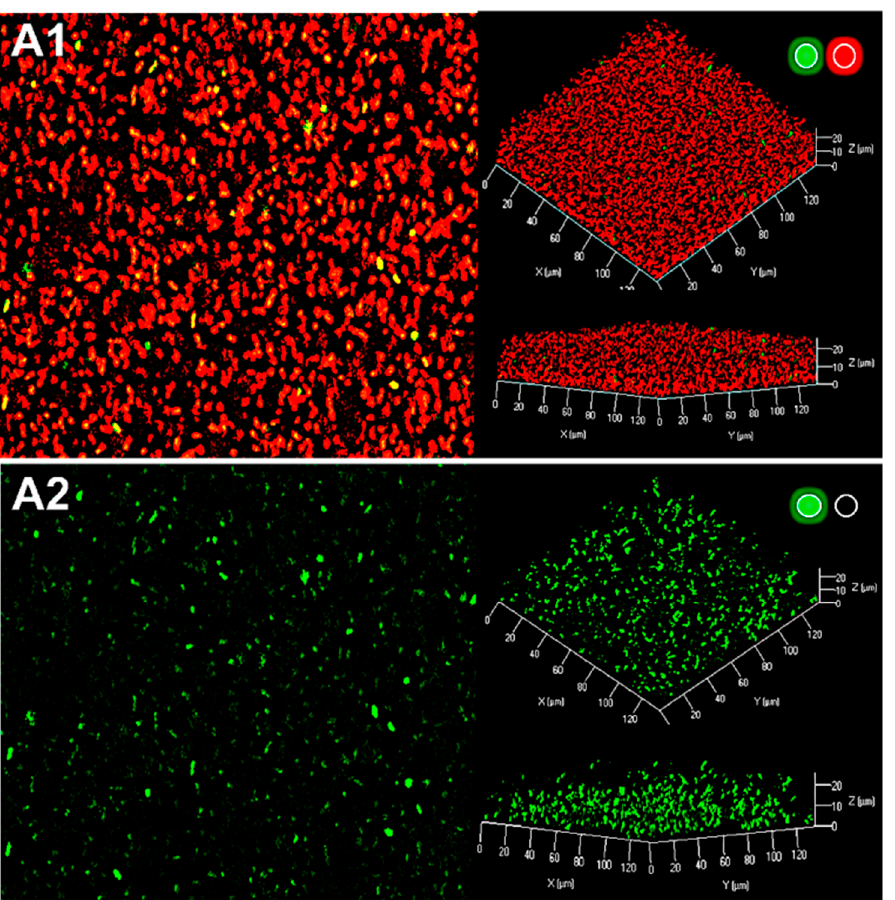
Figure 3. Production of rhizobial AHL signaling molecules within the biofilm. CLSM analysis of the dual-species biofilm formed by R. rhizogenes 5520 T and the P. atrosepticum 6267-EI AHL biosensor strain (1:1 ratio). Bacteria were labeled with the nucleic acid stain Syto 61 (bright red fluorescence), whereas the P. atrosepticum 6276-EI AHL-biosensor was also tagged by GFP, due to the gfp expression governed by the AHL inducible promoter. Top view, 3D shadow representation and side view of the biofilm produced by a mixed culture of R. rhizogenes and P. atrosepticum ( A1,A2 ) . We analyzed the structure of the biofilm (bright red fluorescence) due to the activation of the green plus red channels for ( A1 ), and used the green channel only for ( A2 ), for visualization of the presence of AHL (bright green fluorescence) in the biofilm through the expression of the gfp reporter gene under control of the AHL-inducible promoter (activation of the green or red channel is indicated by a light spot of the corresponding color).